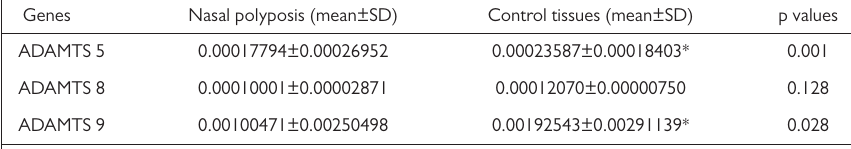
Table 1. The expression levels of the ADAMTS genes in nasal polyposis and normal